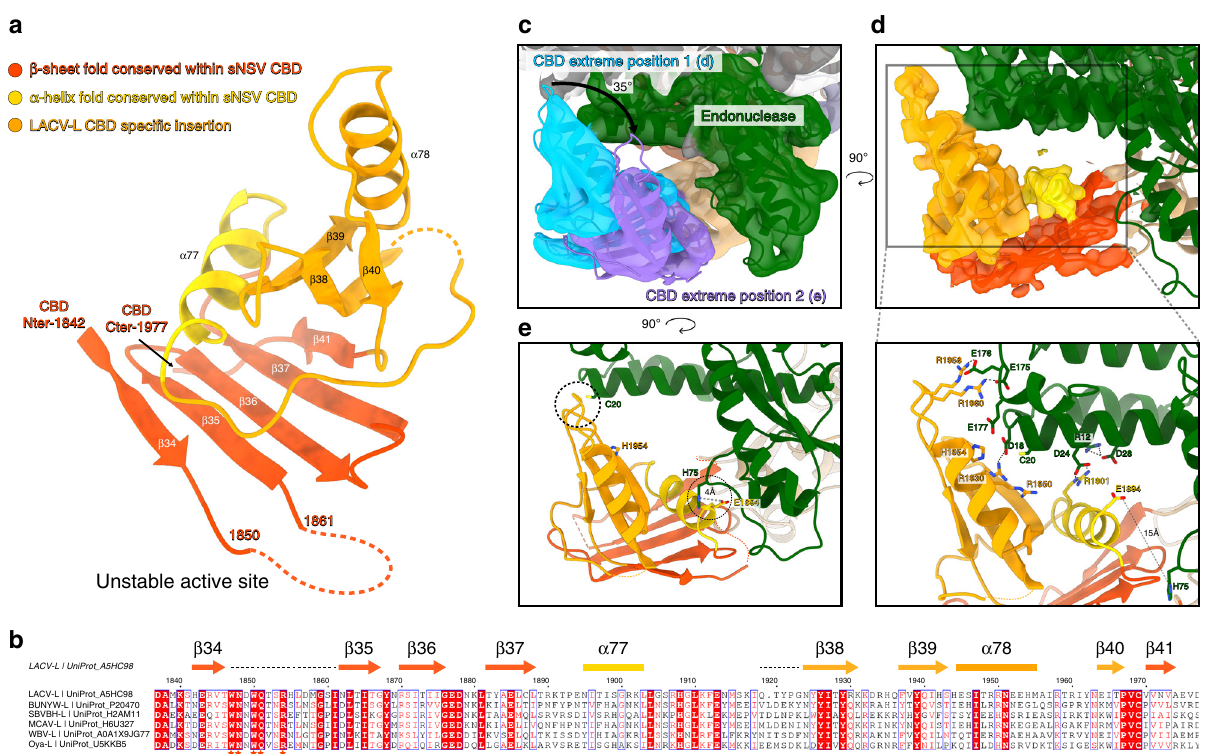
Fig. 3 LACV-L CBD structure and its interaction with the endonuclease. a LACV-L CBD atomic model. Secondary structures are shown. The fold conserved with other sNSV CBD is shown in red and yellow. LACV CBD insertion is shown in orange. The missing loop comprising the active site is shown as a dotted line. b Multiple alignment of six Peribunyaviridae CBD: La Crosse virus (LACV), Bunyamwera virus (BUNYW), Schmallenberg (SVBVH), Macaua virus (MCAV), Wolkberg virus (WBV), and Oya virus. Secondary structures of LACV-L CBD are shown and colored as in a . Missing residues of LACV-L CBD are presented as dotted lines. Conserved residues of Peribunyaviridae CBD active site motif (WNxWQxxR) are shown as orange stars. c Cryo-EM 3D classes corresponding to LACV-L CBD extreme position 1 and 2 are superimposed. CBD movement is compared to LACV-L core and endonuclease that adopt stable positions. Their CBD are, respectively, shown in blue and purple. The endonuclease domain is shown in green. LACV-L core is shown in gray. d Overview and close-up view of the CBD/endonuclease domain interactions in the extreme position 1. Interacting residues are identi fi ed and labeled. CBD coloring is the same as in a . e Overview of the CBD/endonuclease domain interaction in the extreme position 2. Interacting residues are identi fi ed and labeled. CBD side chain positions remain however hypothetical due to the CBD EM map resolution in extreme position